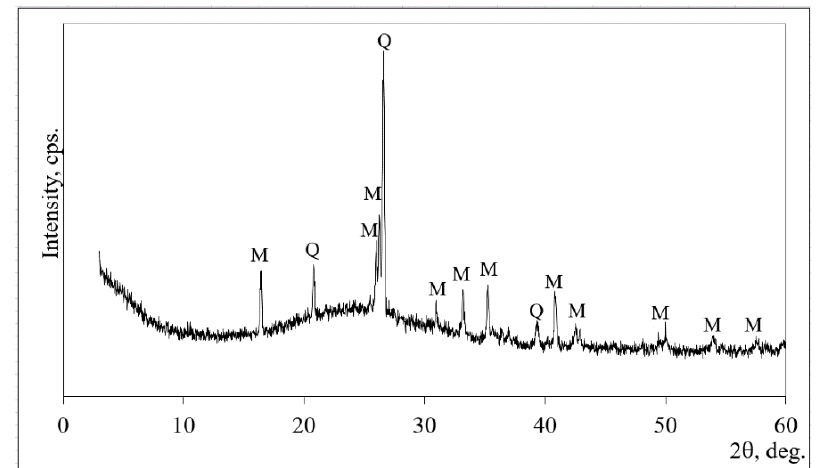
Table 1. Chemical composition of fly ash and ordinary Portland cement.